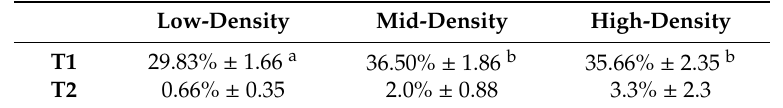
Table 2. Cumulative mortality rate (%) of Siberian sturgeon larvae reared at di ff erent densities at T1 (from T0 to T1) and T2 (from T1 to